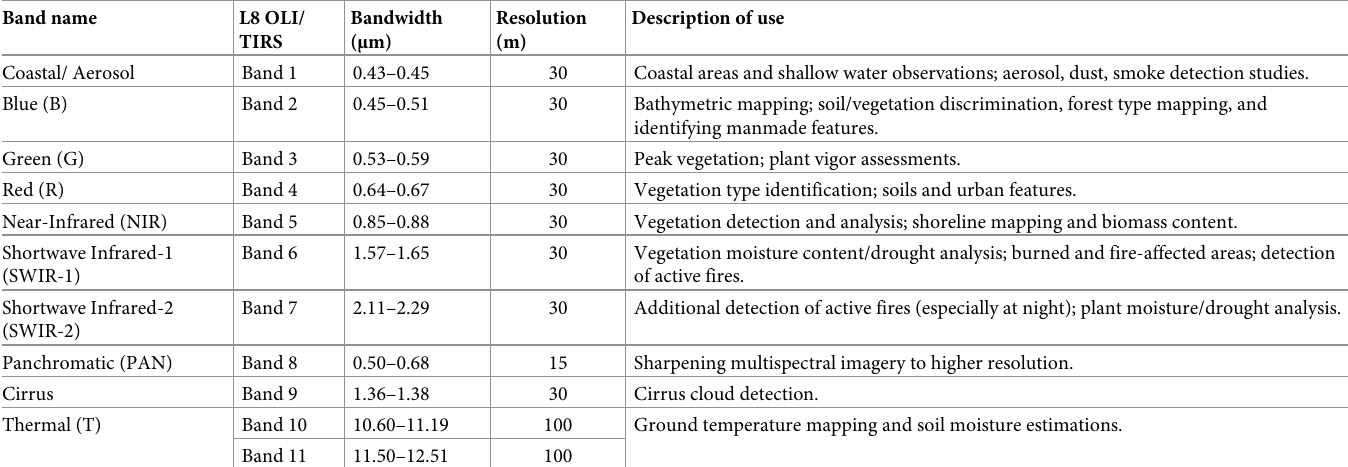
Table 1. Description of uses of Landsat bands (based on